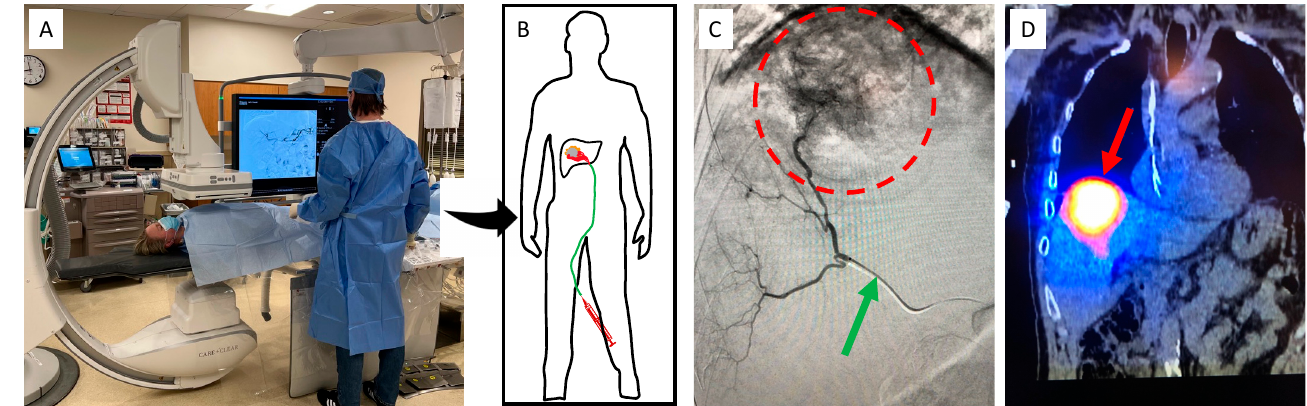
Figure 2. Overview of a fluoroscopy suite and Y90 procedure. Patients are placed on a bed underneath a fluoroscopy machine ( A ), which allows the physician to use image guidance to guide a catheter to the point of interest ( B ). Fluoroscopic imaging ( C ) allows visualization of a radio-opaque catheter (green arrow), which can be used to inject contrast dye that outlines the vessels feeding the tumor (red circle). Once in the proper location, therapeutic Y90 can then be delivered, and follow-up SPECT imaging ( D ) can confirm retention in the tumor.